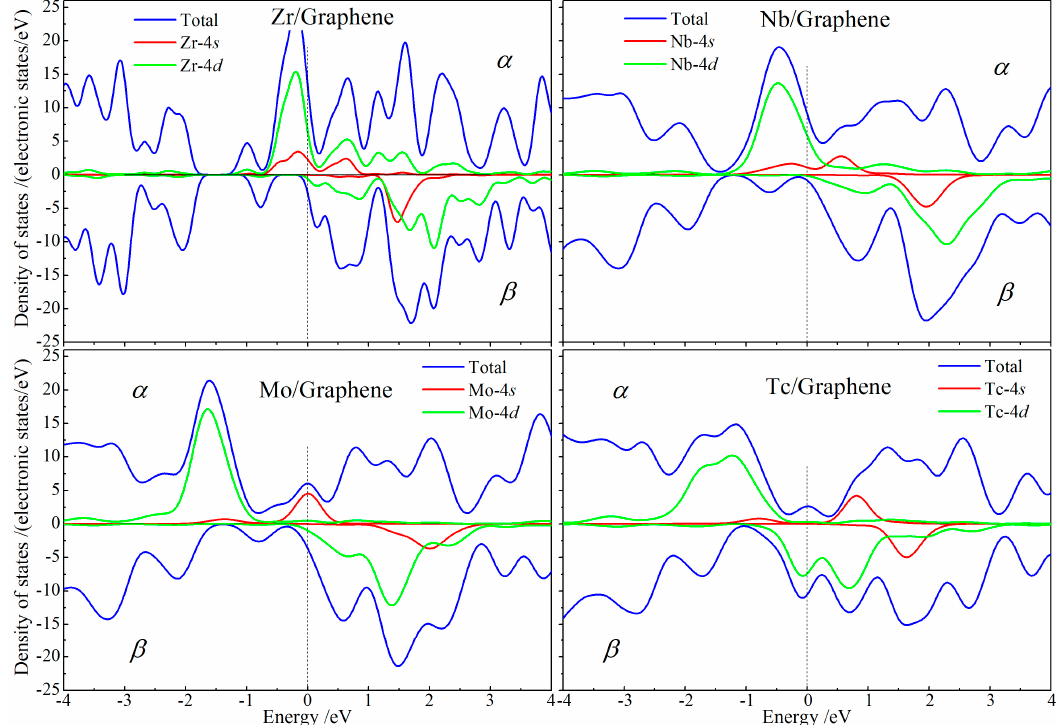
Figure 4. Spin-dependent partial density of states (PDOS) of Zr, Nb, Mo and Tc/graphene B-site adsorptions with the Fermi-level (vertical dash line) being referenced as energy zero and a Gaussian smearing of 0.1eV.